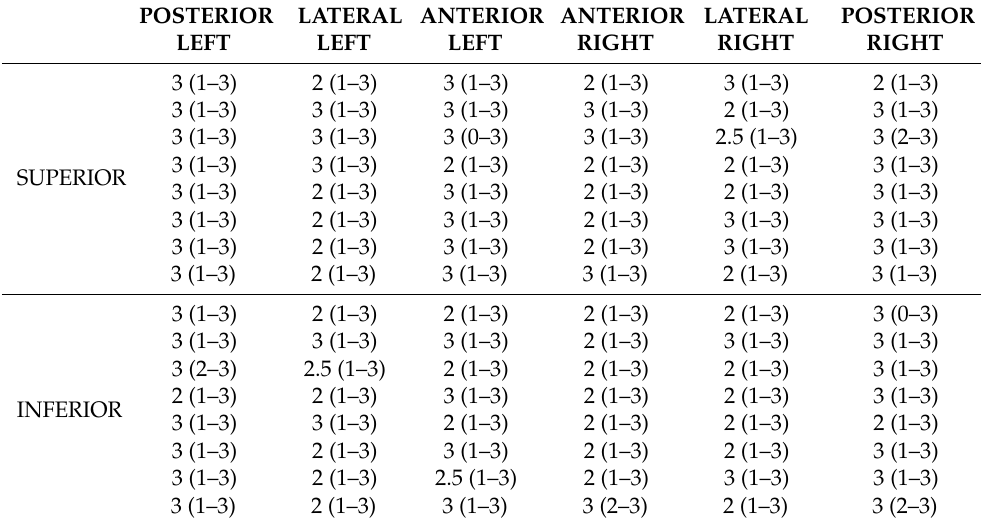
Table 1. Overall evaluation of LUS quality by the 2 reviewers per each scanning area. POSTERIOR LATERAL ANTERIOR POSTERIOR LATERAL ANTERIOR ANTERIOR LEFT LEFT LEFT RIGHT RIGHT LEFT LEFT LEFT RIGHT RIGHT